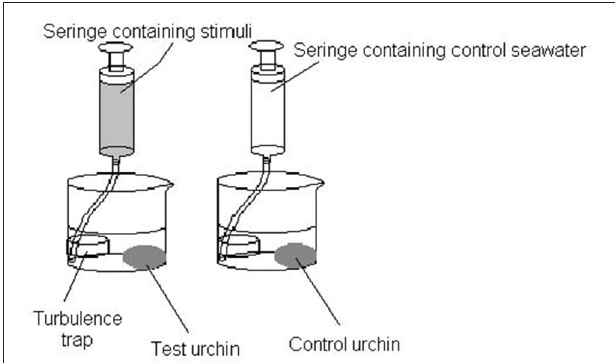
FIGURE 1 | Side view of the stimulation apparatus used to introduce dissolved stimuli and control seawater in a controlled and non-turbulent